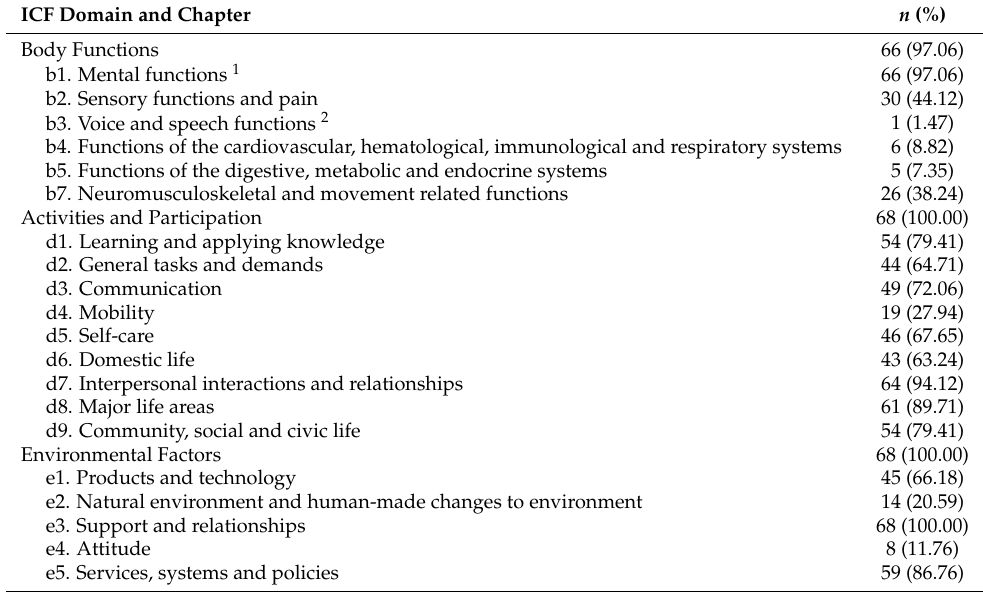
Table 2. Frequency ( n and %) of caregivers reporting a support need and/or suggested support related to each domain and chapter of the International Classification of Functioning, Disability and Health (ICF